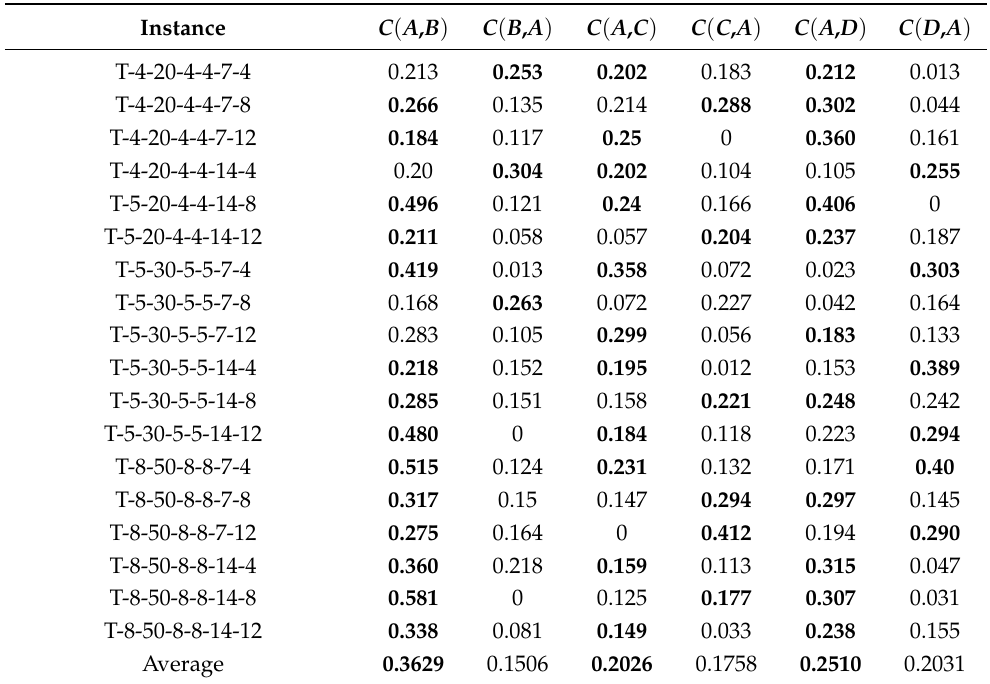
Table 13. Results of the numerical experiments (A: PICEA-g-AKNN, B: PICEA-g, C: MOEA/D, D: